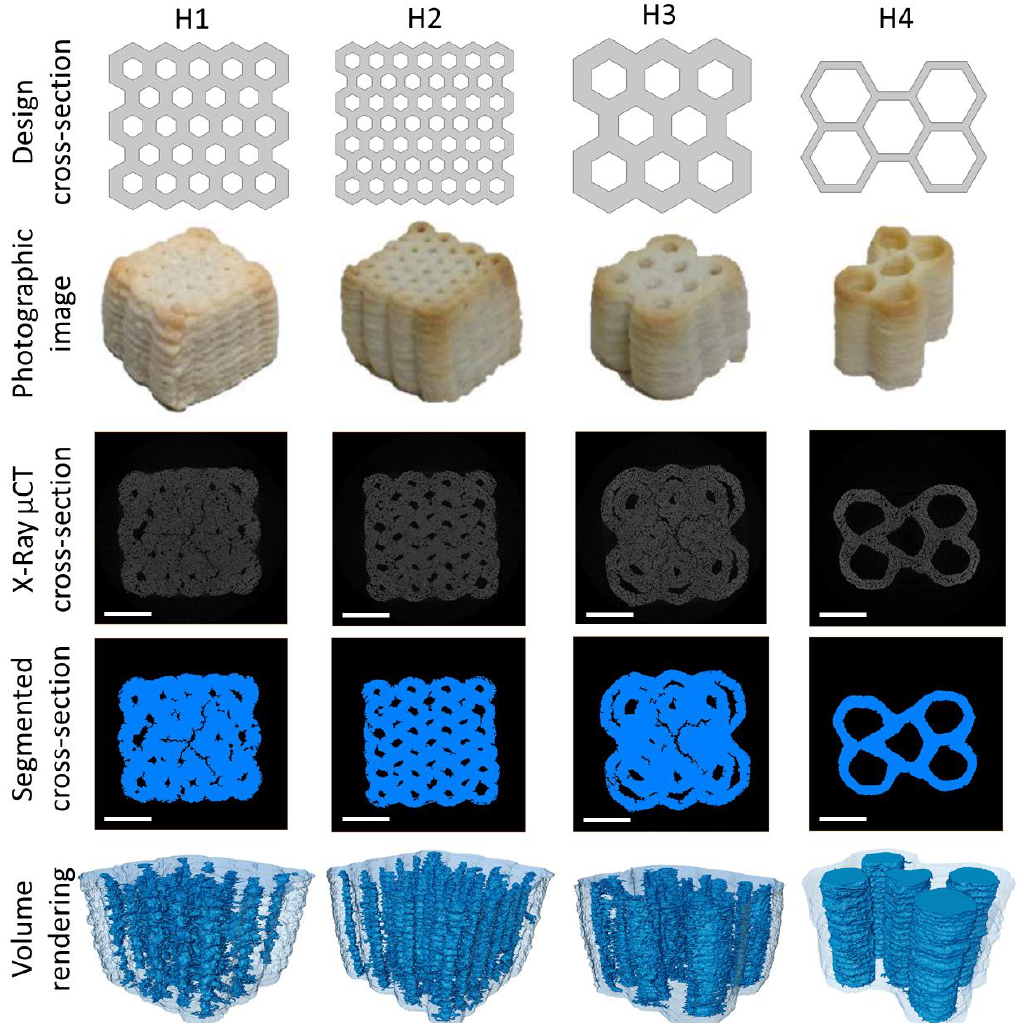
Figure 8. Cross-section design ( row 1 ), photographic image ( row 2 ), X-ray µCT image slice ( row 3 ), segmented X-ray µCT image slice ( row 4 ), and volume rendering ( row 5 ) of the four experimentally tested honeycomb structures. The scale bar of µCT images corresponds to 10 mm.